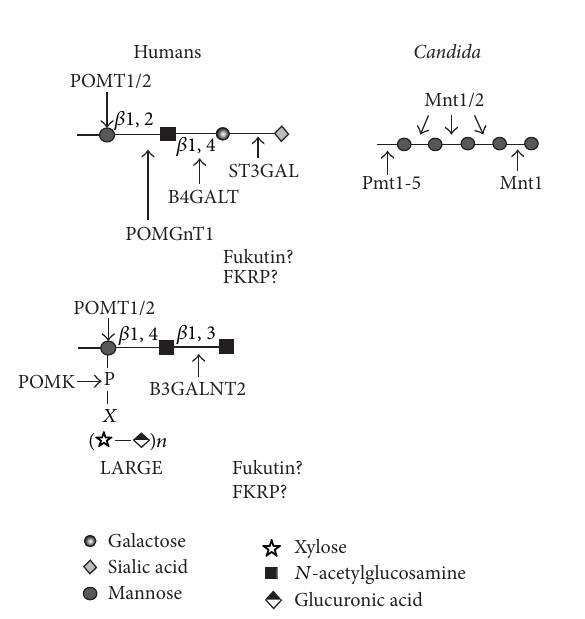
Figure 2: The O -linked mannosylation pathway. Human O - linked mannosyl glycans have been characterized mainly in alpha- dystroglycan where POMT1/2 add the first mannose residue that is further extended with other monosaccharides by the action of glycosyltransferases. The mannose residue can also be phospho- rylated by the action of POMK, allowing further modification by disaccharide repeats of xylose and glucuronic acid synthesized by LARGE and LARGE2. Fukutin and FKRP genes are needed for correct glycosylation, but their roles remain to be clearly defined. In C.albicans ,mannosylationinvolvestheadditionofthefirstmannose residue by the action of Pmt1-5, and that is further extended with four additional mannose residues by the action of Mnt 1 and